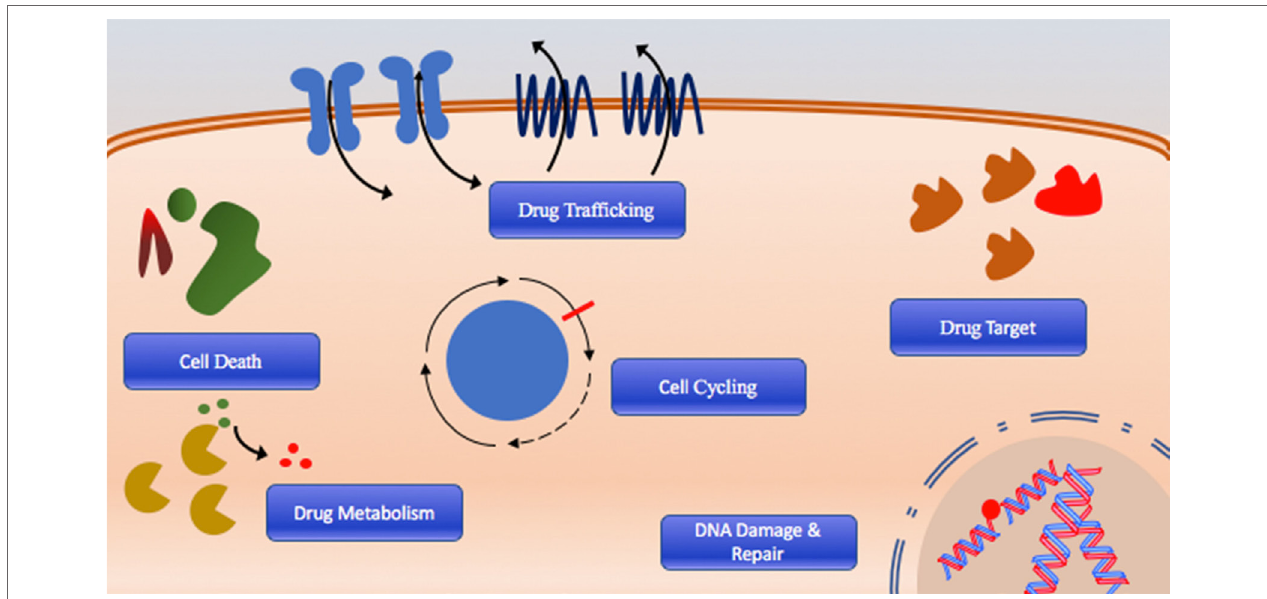
FigURe 1 | The six hallmarks of drug resistance: DNA damage and repair dysregulation, cell cycle dysregulation, cell death evasion, altered drug metabolism, altered drug target, and dysregulated drug trafficking.